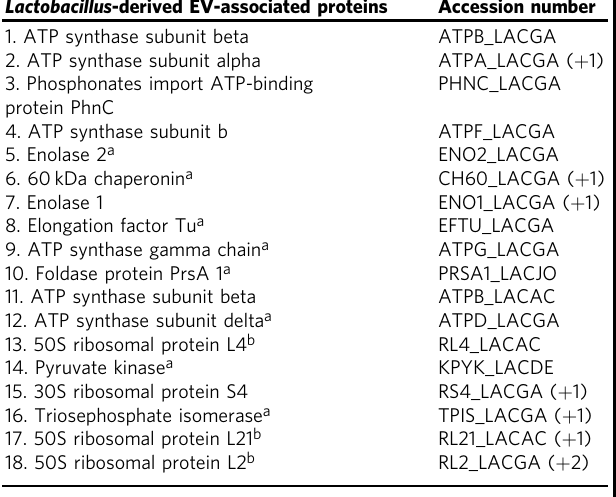
Table 1 Protein cargo of EVs derived from L. gasseri BC12 and L. crispatus BC5.